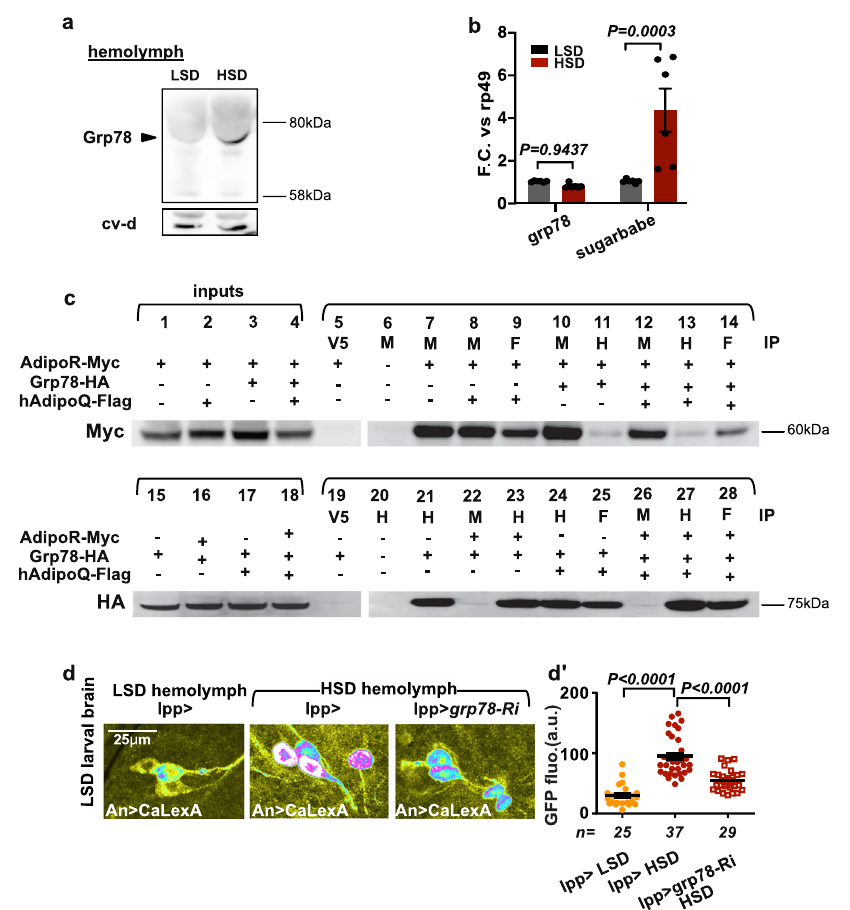
Fig. 2 Grp78 is a sugar-induced inhibitory partner for AdipoR. a Grp78 immunodetection in the hemolymph of low (LSD) and high (HSD) sugar diet-fed larvae. Cv-d is a control for hemolymph proteins. (the experiment was repeated three times independently with similar results). b grp78 RNA levels in the whole larva in LSD (grey) versus HSD (red). qRT-PCR pro fi les, fold changes (FC) normalized to rp49 . sugarbabe serves as a control for sugar induction. Statistical signi fi cance was tested using ordinary two-way ANOVA with Sidak ’ s multiple comparisons test. n = 3 biologically independent replicates per experiment (two independent experiments). c Co-immunoprecipitations (co-IP) of AdipoR-Myc, Grp78-HA, and hAdipoQ-Flag expressed in S2 cells. Inputs (lanes 1 – 4; 15 – 18). Myc (M), HA (H), and Flag (F) IPs are used to visualize AdipoR-Myc (5 – 14) or Grp78-HA (19 – 28). (the experiment was repeated three times independently with similar results). d Brain from Apn > CaLexA larvae fed in LSD and incubated with the hemolymph from lpp > control larvae (LSD- n = 25, orange or HSD-fed n = 37, red points) or lpp > grp78-Ri larvae ( − 40%; HSD-fed n = 29, red squares). d ′ Quanti fi cation of GFP fl uorescence in APN. n = independent averaged GFP intensity measurements in APN. Statistical signi fi cance was tested using a two-sided Mann – Whitney test. Data were presented as mean values ± SEM. P values are indicated in all panels. a.u. arbitrary units. Source data are provided as a Source Data fi